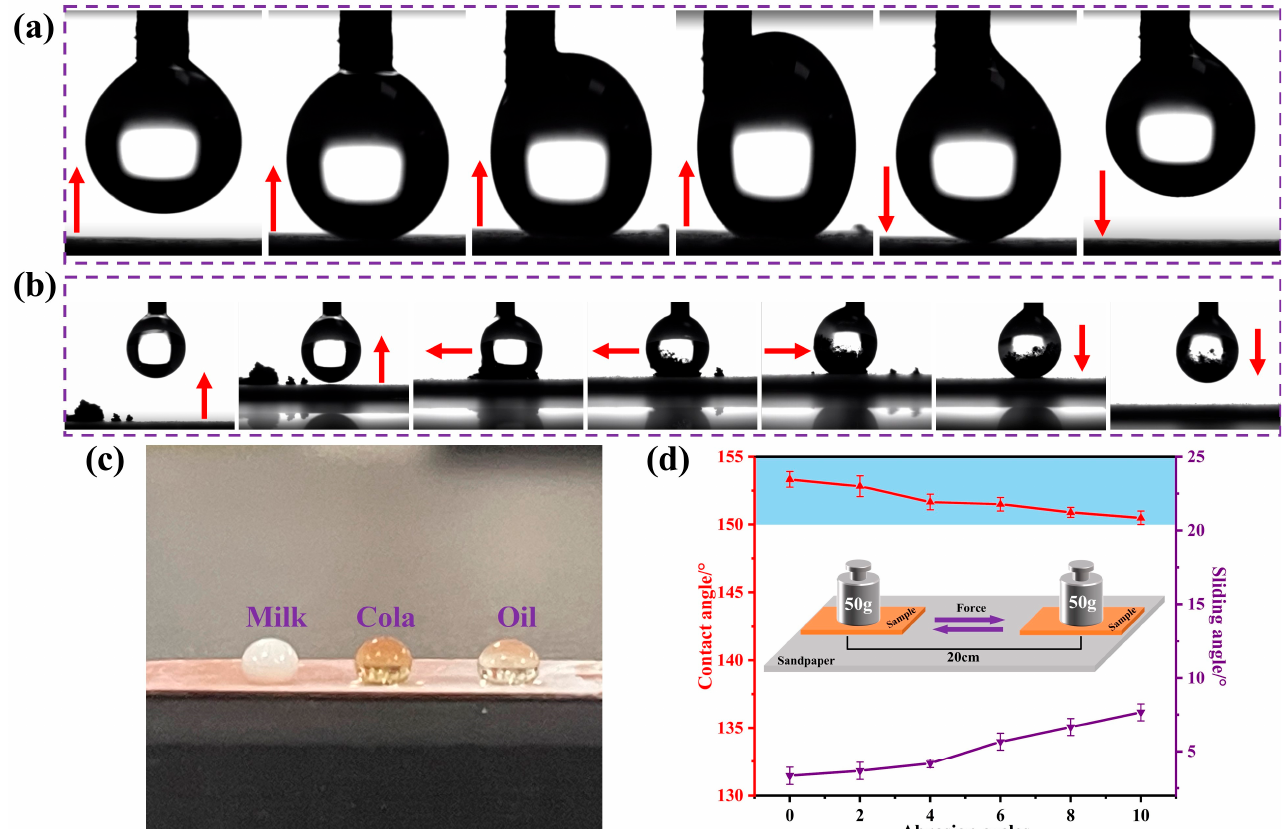
Figure 13. ( a ) The process of anti-sticking test of superhydrophobic surface (arrows indicating the platform moving direction). ( b ) The process of dust adsorption test by a water droplet on superhy- drophobic surfaces (arrows indicating the platform moving direction). ( c ) Photographs of different liquid droplets on the coating surface (contact angles being 151°, 151.5°, and 129° respectively). ( d ) WCAs and sliding angle of the coating in relation to the abrasion cycle by